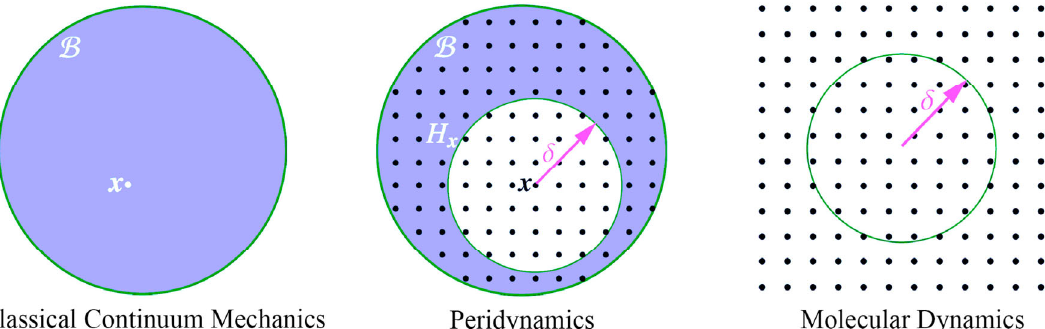
Fig. 84 Comparison of CCM, PD, and MD. CCM and PD are formulas defined on continuum B. PD is divided into points with finite volume. In CCM, the state of a point is only affected by its immediate neighbors. In PD, a particle x interacts with other particles within a neighborhood H x bounded by the horizon δ . MD analyzes the interactions between discrete atoms whose interactions are governed by the cutoff radius δ . PD is similar to CCM in that it is still a continuous formulation, and similar to MD in that it is nonlocal and borrows some concepts from MD, such as the cutoff radius δ [990]. Reproduced with permission from Ref. [990], © The author(s),